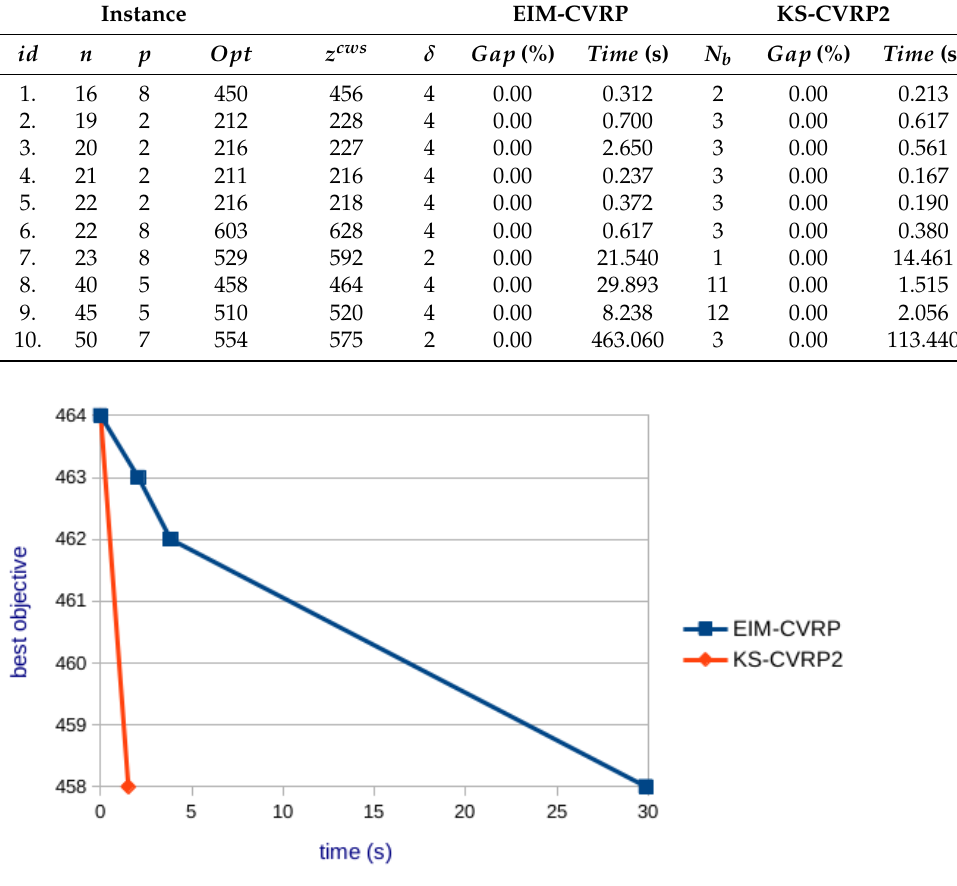
Figure 4. Time evolution of the solution by different